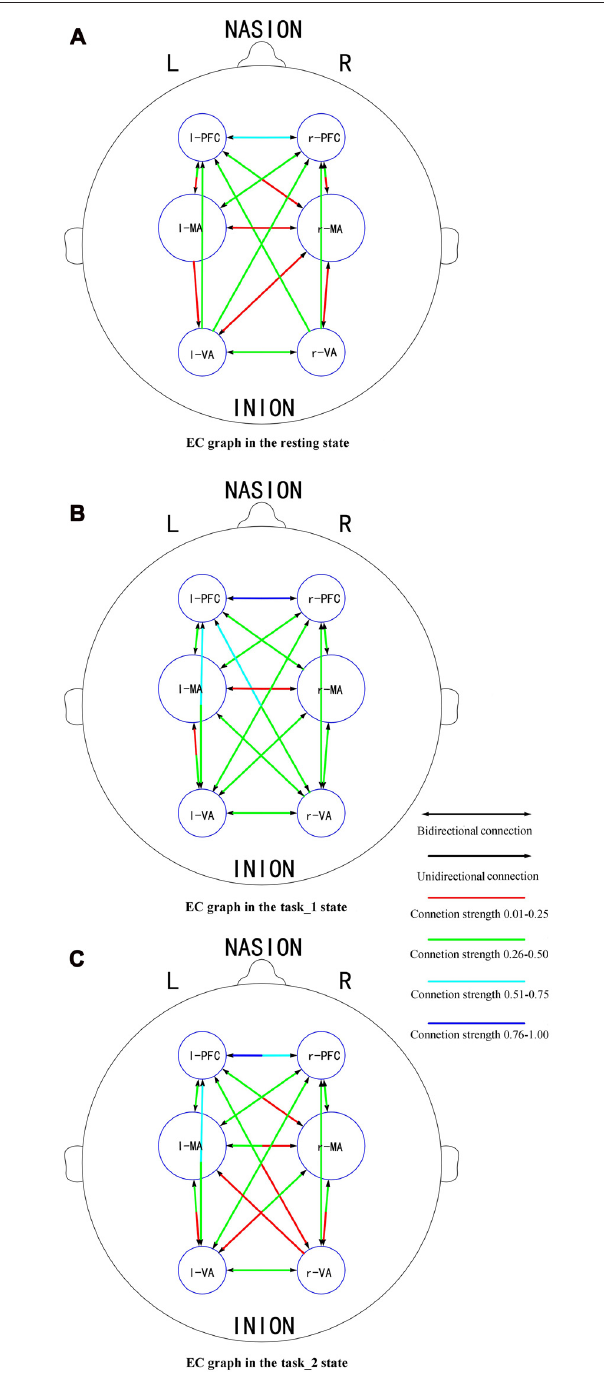
FIGURE 6 | EC graphs of six brain areas in the (A) (resting), (B) (task_1) and (C) (task_2) states, respectively. The connection with double-headed arrows denotes the connection in EC is bidirectional. The connection with single head arrow denotes the connection in EC is unidirectional. Different colors represent different connection strength. The colder color represents the stronger connection strength. Abbreviations: r-PFC, right prefrontal cortex; l-PFC, left prefrontal cortex; r-MA, right motor-related areas; l-MA, right motor-related areas; r-VA, right vision-related areas; l-VA, left vision-related areas; EC, effective connectivity.